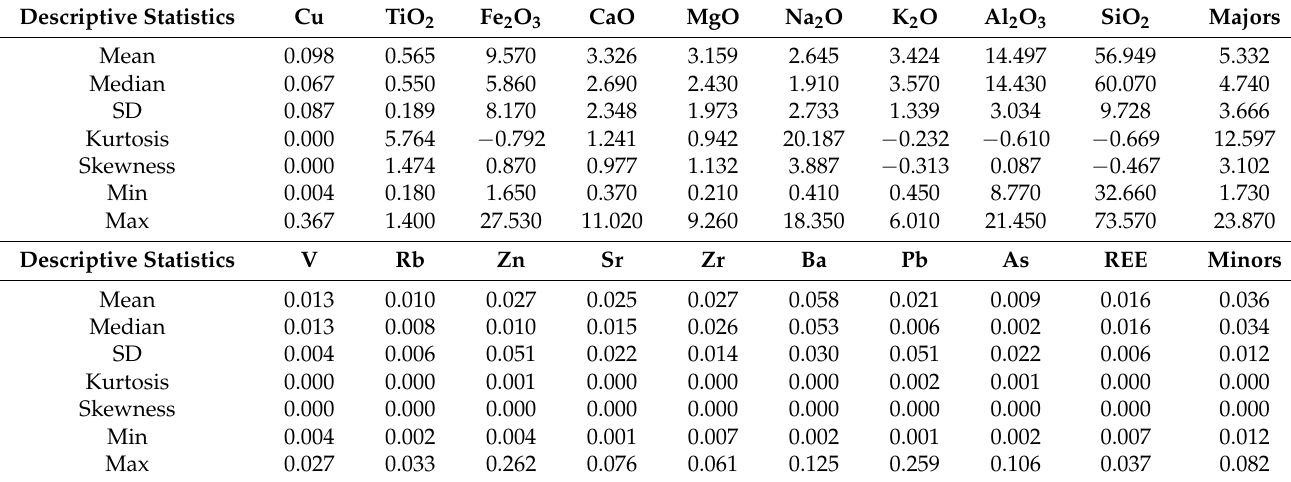
Table 2. Descriptive statistics of chemical composition and concentration (wt.%) of tailing deposits active in Chile: values calculated based on data. REE: rare earth elements; SD: standard deviation.